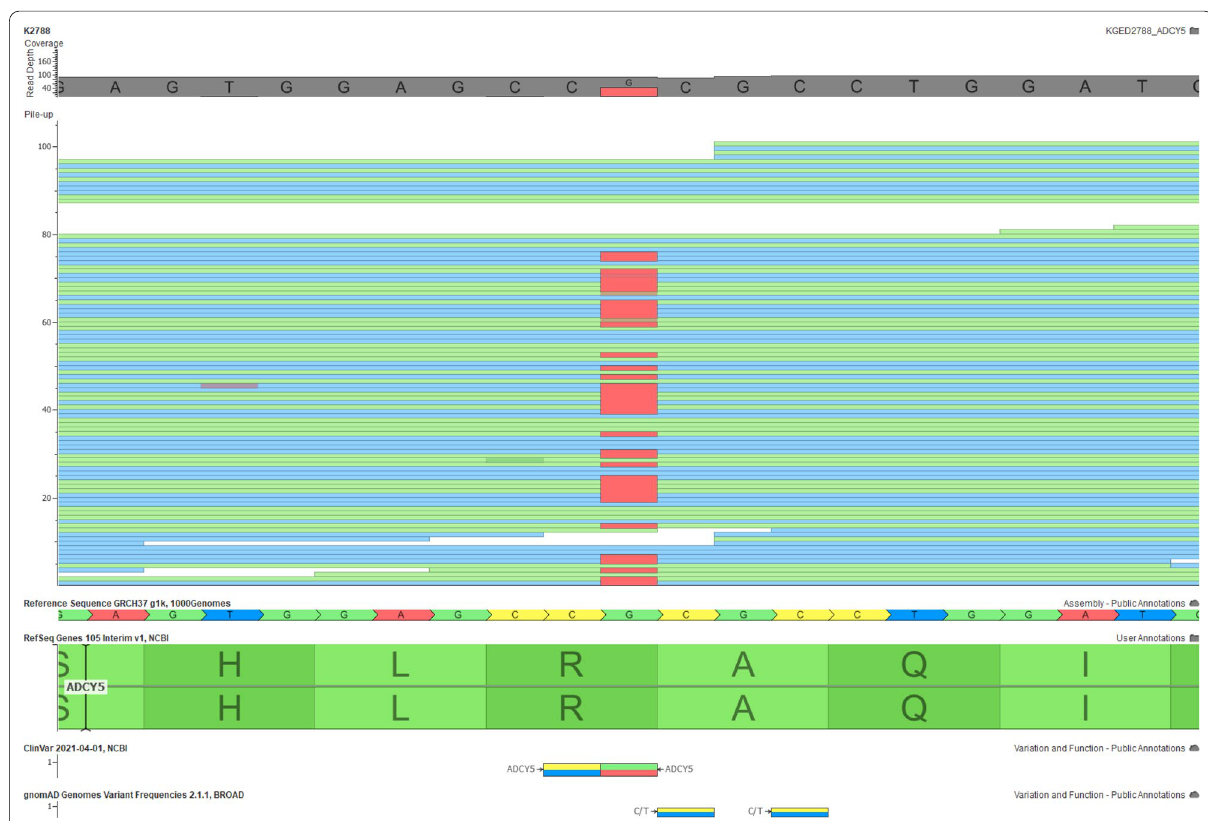
Fig. 1 Whole‑exome sequencing in the proband. The figure shows the alignment of the reads around the pathogenic variant (c.1252C>T:p. Arg418Trp) of the BAM file visualized using the GenomeBrowse software (Golden Helix, Inc. USA) (https:// www. golde nhelix. com/ produ cts/ Genom eBrow se/). The top panel illustrates the coverage of the reads, and the middle panel shows the actual mapping of the reads with blue indicating forward reads and green indicating reverse reads. The bottle panel shows the reference genome (CRCH37) and information from the gnomAD and ClinVar